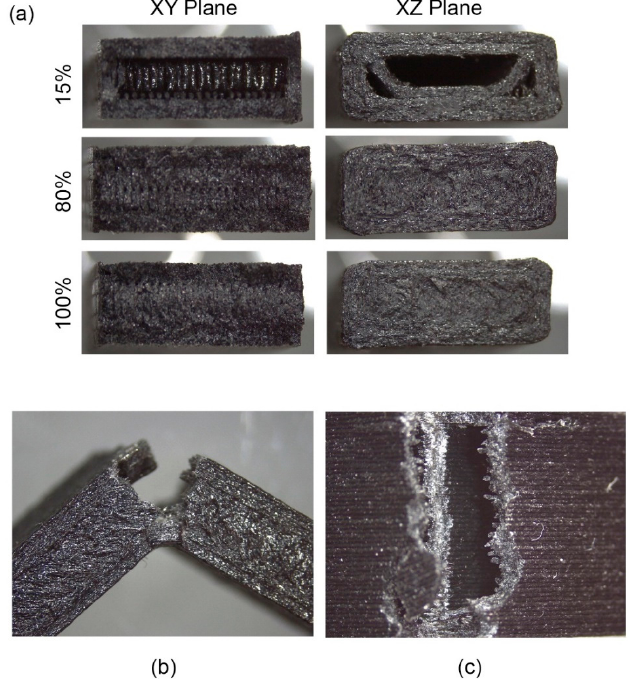
Figure 6. ( a ) Fracture surfaces from the Charpy impact test samples: ( b ) side view and ( c ) top view of the sample built on the XY plane with a filling percentage of 15% that has not been broken.